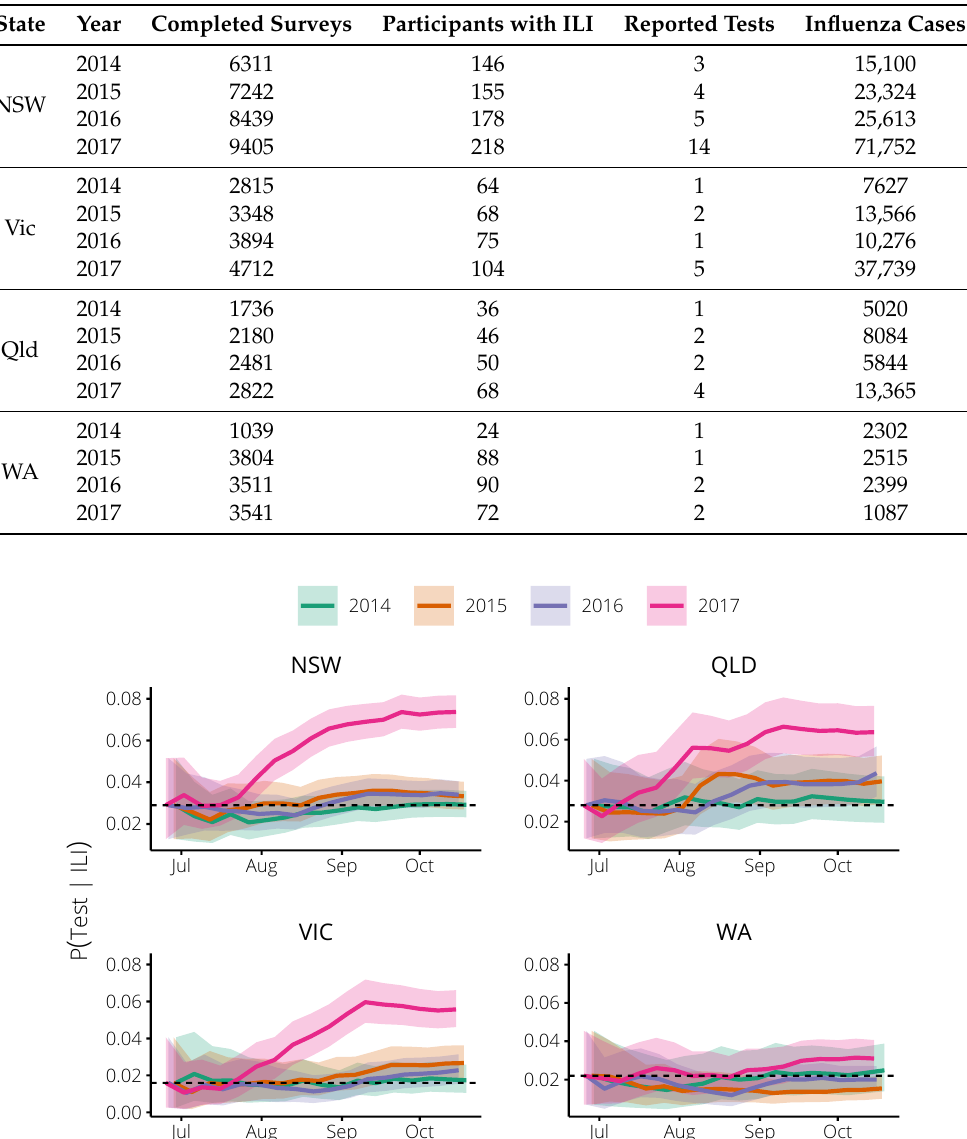
Table 1. Flutracking mean weekly count of completed surveys, participants with ILI and participants with ILI who sought health advice and reported being tested for influenza (regardless of the test result), and the total number of influenza cases reported in each city; 2014–2017, NSW, Vic., Qld, and WA.